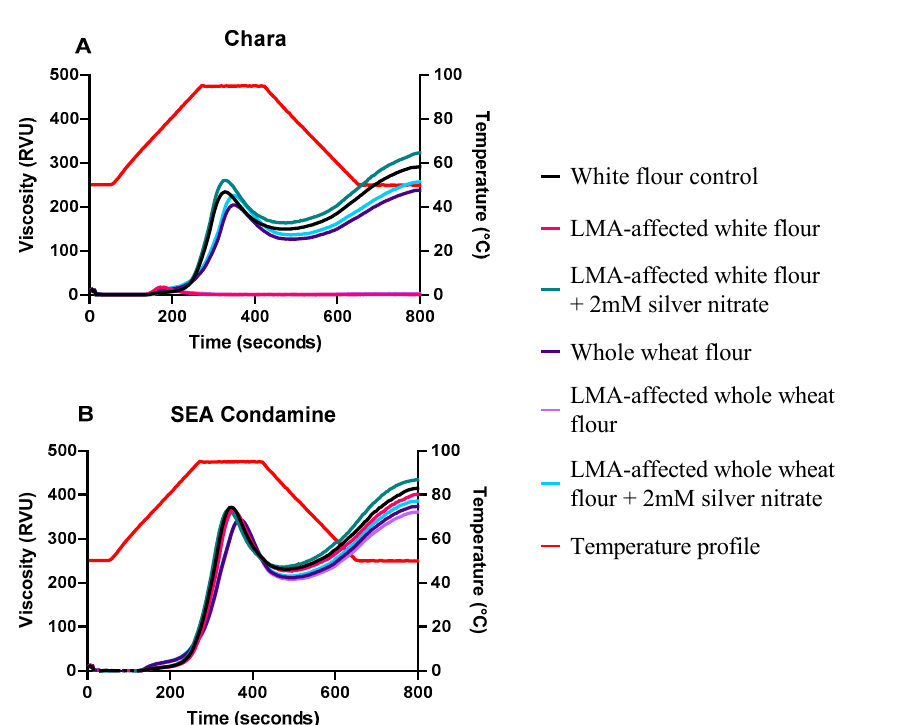
Figure 3. RVA Pasting Profiles of ( A ) Chara and ( B ) SEA Condamine. RVA viscogram illustrating pasting behaviour of